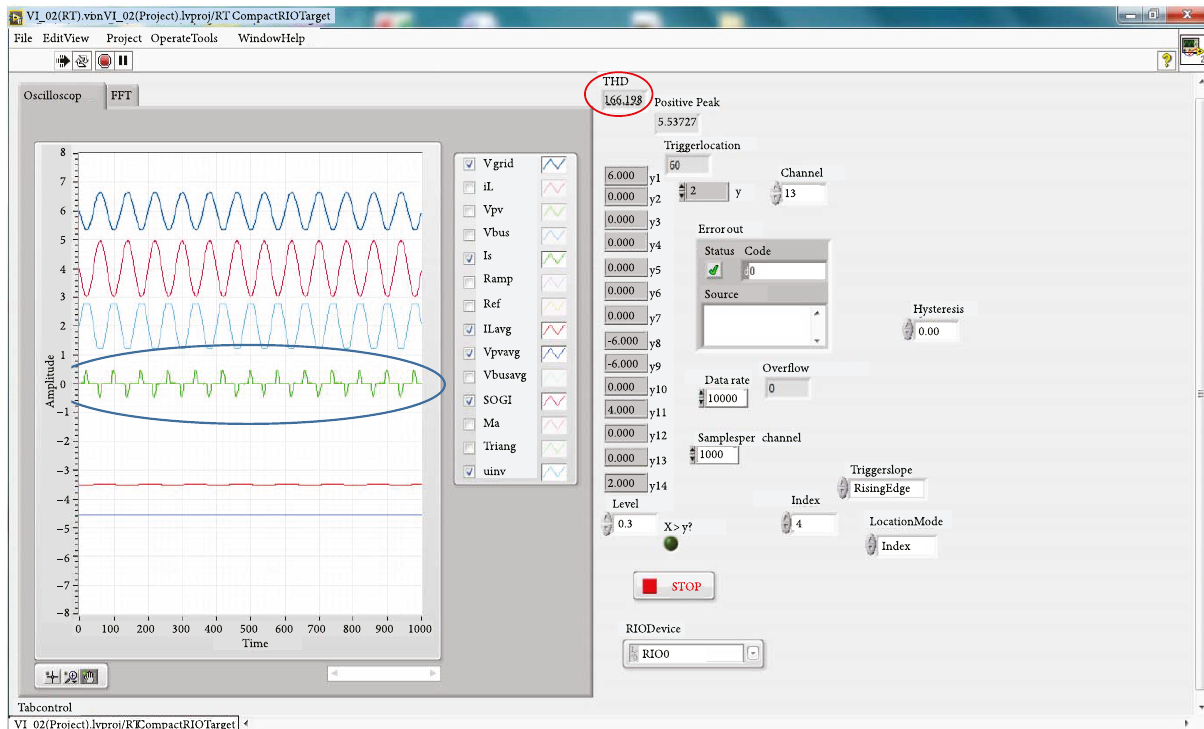
Figure 3: Implemented LabVIEW control